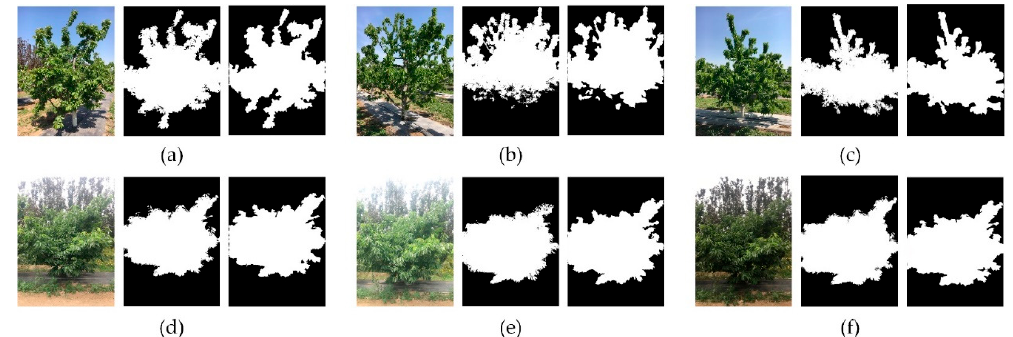
Figure 11. Comparison of segmentation results under different overlapping conditions and at different day times: ( a ) samples under a slightly overlapping condition; ( b ) samples under a partially overlapping condition; ( c ) samples under a highly overlapping condition; ( d ) samples collected in the morning; ( e ) samples collected at noon; and ( f ) samples collected in the